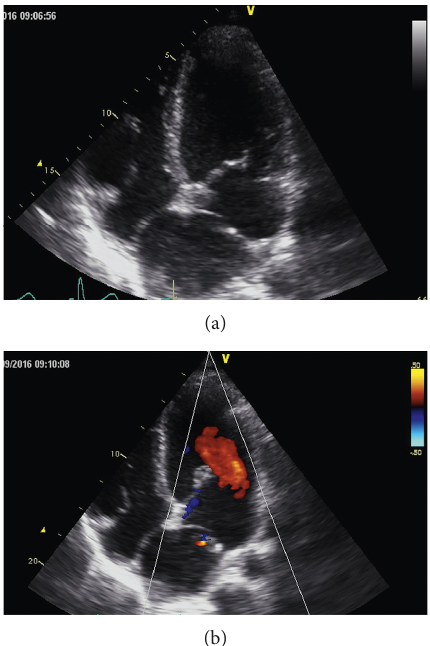
Figure 1: (a) An apical four-chamber view demonstrating a markedly dilated left atrium separated into two chambers by a membrane. (b) Colour Doppler images demonstrating flow across the fenestration in the membrane and across the mitral valve.